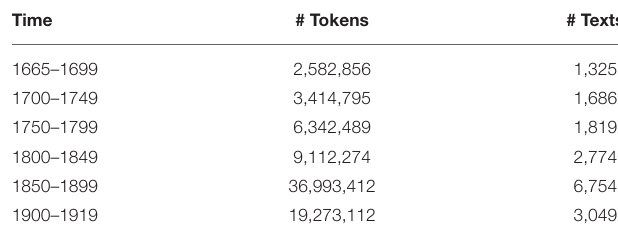
TABLE 1 | Size of RSC 6.0 by 50-year